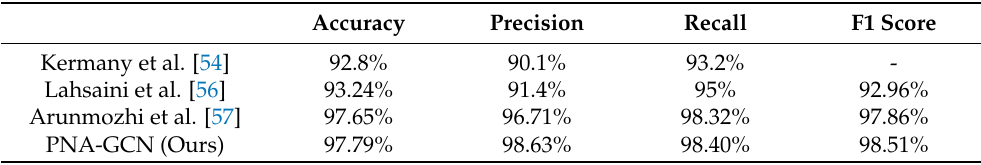
Table 3. Comparison of results.